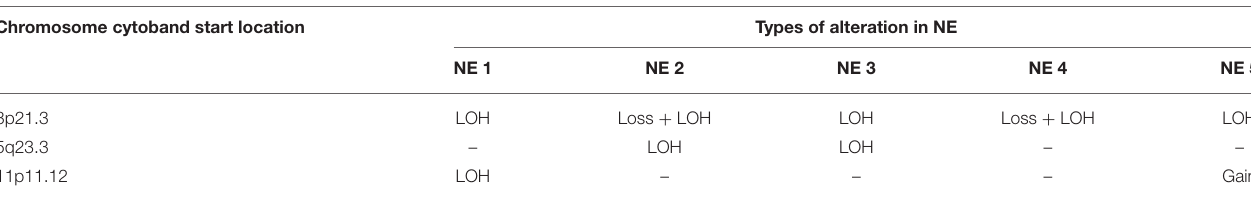
TABLE 3 | Genetic alterations common to at least two